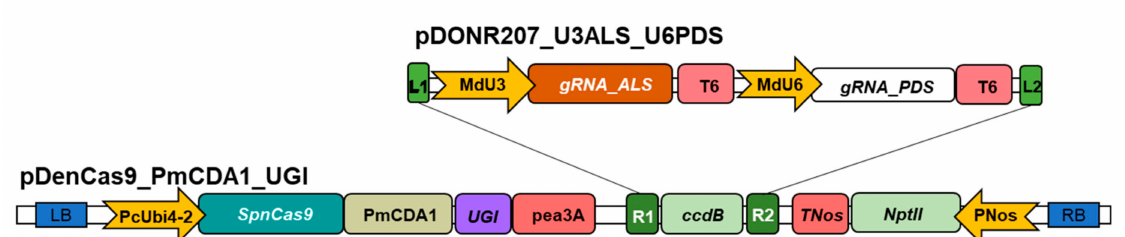
Figure 5. CRISPR/nCas cytidine base editing vector construction. Two single guides RNAs, specifically chosen for targeting the genes ALS and PDS were assembled on the pDORN207 vector and later introduced into final vector pDen- Cas9_PmCDA1_UGI by Gateway LR recombination. The nickase Cas9 gene ( SpnCas9 ) from Streptococcus pyogenes is driven by PcUbi4-2 promoter (P) from parsley ( Petroselinum crispum ) followed by Petromyzon marinus cytidine deaminase (PmCDA1) and uracil DNA glycosylase inhibitor protein (UGI) with transcription termination by the pea3A terminator (T) from pea ( Pisum sativum ). gRNA_ALS and gRNA_PDS are, respectively, driven by MdU3 and MdU6 promoters from M. domestica and transcription is terminated by a polyT terminator. Transformants are selected with a nptII gene controlled by nos promoter and terminator from Agrobacterium tumefaciens . L1 and L2, R1 and R2: Att sites for Gateway LR recombination. LB and RB: T-DNA